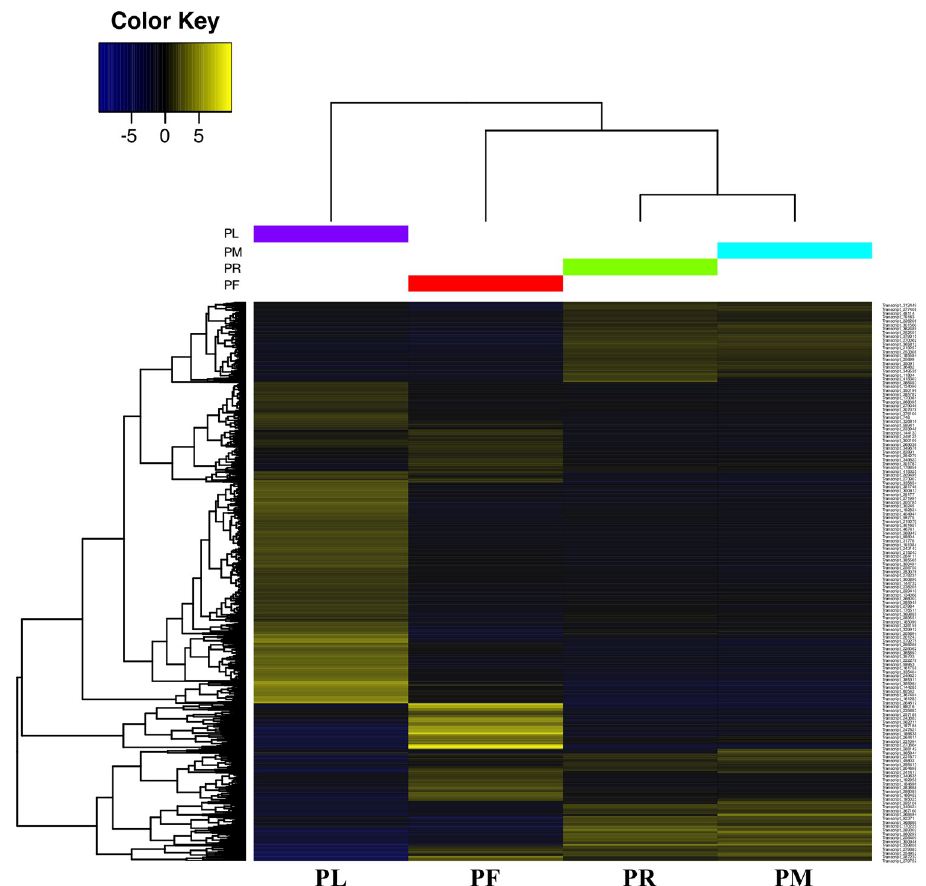
Fig 4. Heatmap of the expressed transcripts in all four tissues. All the transcripts with expression in all four tissues are included. Yellow depicts higher value and blue depicts lower value. PL: leaf, PF: inflorescence, PM: shoot meristem, and PR: rhizome. The set of scripts from Trinity-2.8.4 was used to generate the diagram [22].